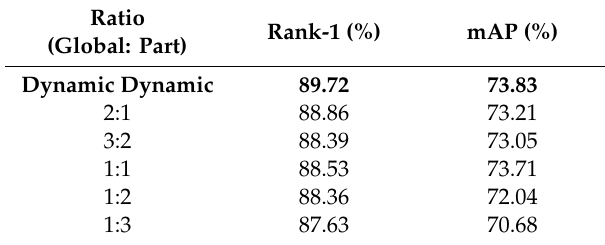
Table 3. Performance with di ff erent loss